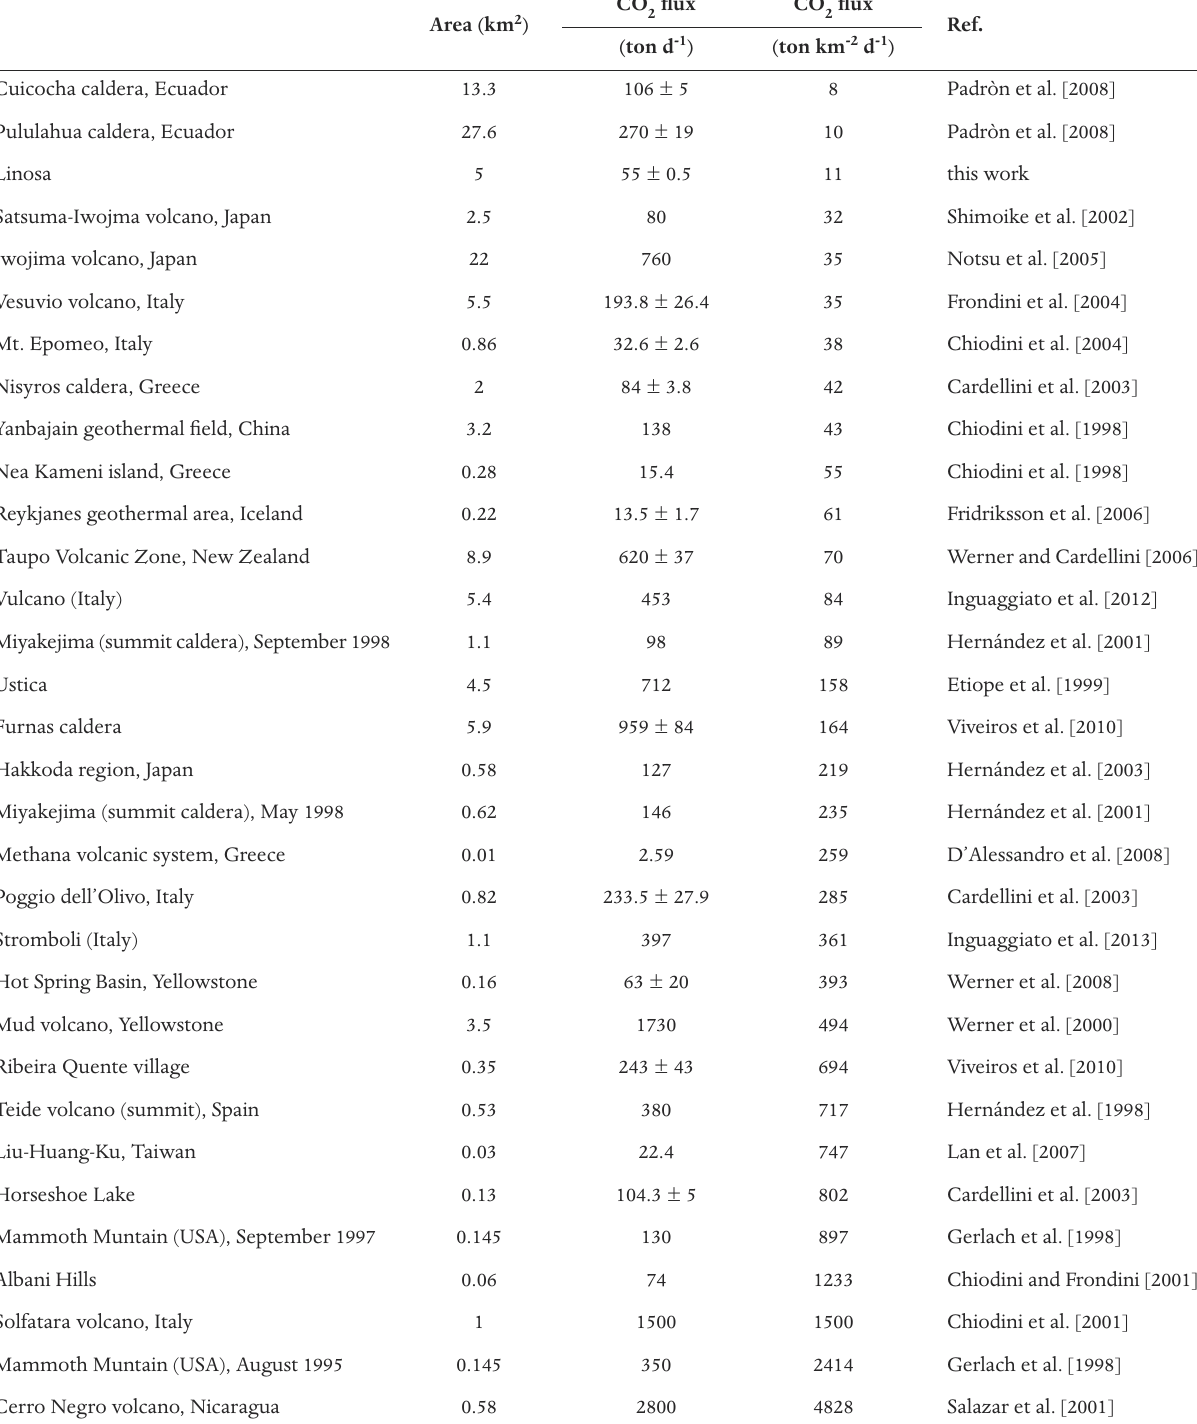
Cerro Negro volcano, flux output estimated for the island of Linosa compared with those of some active volcanoes and those of tectonic, hy- Table 2. Total CO 2 drothermal or inactive volcanic areas; data are sorted based on CO